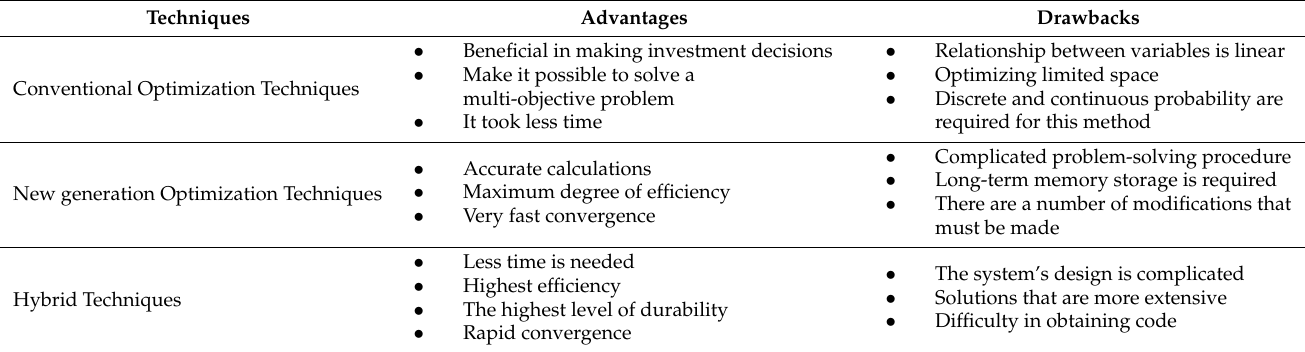
Table 5. Benefits and downsides of each optimization techniques [19,20,26,91].